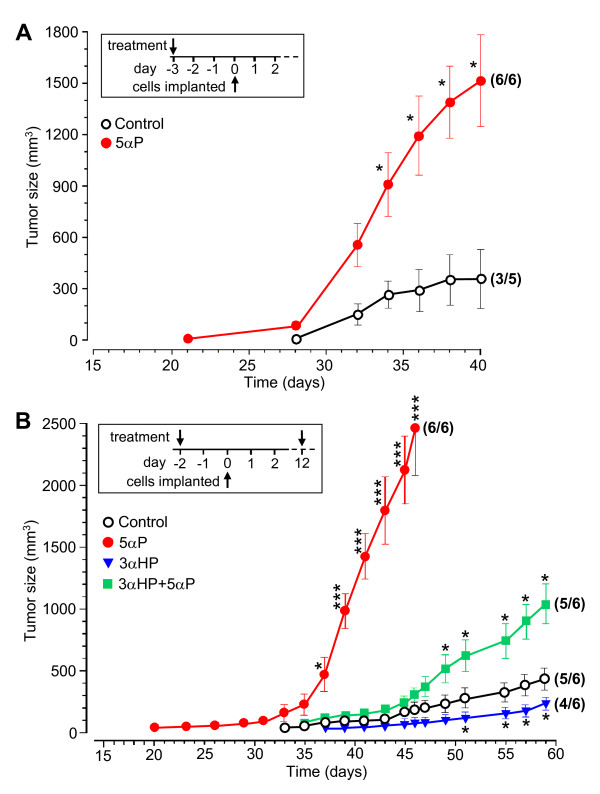
ER/PR-negative breast cell tumor induction and growth are regulated by 5αP and 3αHP. (A) Tumor induction and growth are stimulated by 5αP. MDA-MB-231 cells were implanted in mammary fat pads of 11 mice (day 0, inset); 3 days before (day -3), five mice were injected with vehicle (control; black open circles), and six were injected with 5αP (red, solid circles). Data points represent size (mm3; mean ± SEM) of tumors that developed of a total number of mice per treatment (bracketed values), and the experiment was terminated on day 40. *Significantly different from controls at P < 0.05. (B) Tumor induction and growth are stimulated by 5αP and inhibited by 3αHP. Twenty-four mice were divided into four groups of six mice each, and MDA-MB-231 cells were implanted on day 0 (inset). Two days before (day -2) and on day 12, mice were injected with either vehicle (control; black open circles), 5αP (red, solid circles), 3αHP (blue inverted triangles), or 5αP+3αHP (green squares). The 5αP-treated mice were terminated on day 46 because of tumor burden, and the other mice were terminated on day 59. Data points represent size (mm3; mean ± SEM) of tumors that developed of a total number of mice per treatment (bracketed values). Significantly different from controls at *P < 0.05 and ***P < 0.001.